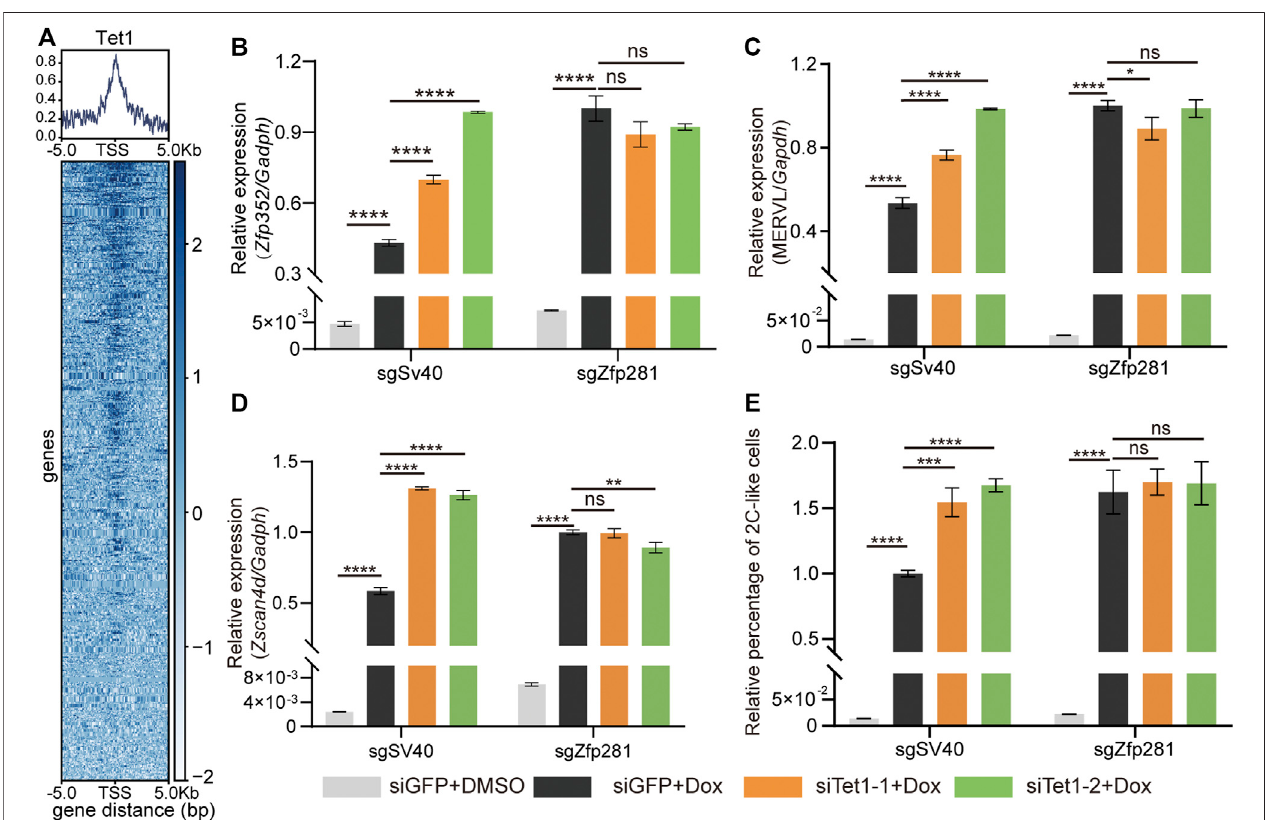
FIGURE 3 | Zfp281 represses the 2C-like transition through Tet1. (A) Average occupancy plots and heatmaps of Tet1 signal within 5 kb of the center of TSS (transcription start sites) region of the Zfp281-bound-2C-upregulated genes. (B – D) Relative mRNA levels of Zfp352 (B) , MERVL (C) , and Zscan4d (D) normalized to Gadph in mESCs upon indicated manipulation. Zfp281 majorly impedes the pluripotent-to-2C-like state transition ( Figure 2 ). To accurately analyze the effect of Zfp281 on 2C-like transition, all results are analyzed at 12 h after synDux induction, when most mESCs are transiting into 2C-like state (Fu et al., 2019). (E) The relative percentage of 2C-like cells in mESCs upon indicated manipulation. (B – E) The siTet1-1/2 represents two independent siRNA targeting Tet1, siGFP is the negative control. Dox represents doxycycline. The X in sgX refers to the gene that sgRNA targets to; sgSv40 is negative control. Shown are mean ± s.d, n = 3. p Values were calculated by the parametric one-way analysis of variance (ANOVA) test, ns = no signi fi cance, ** < 0.01, *** < 0.001, **** < 0.0001.